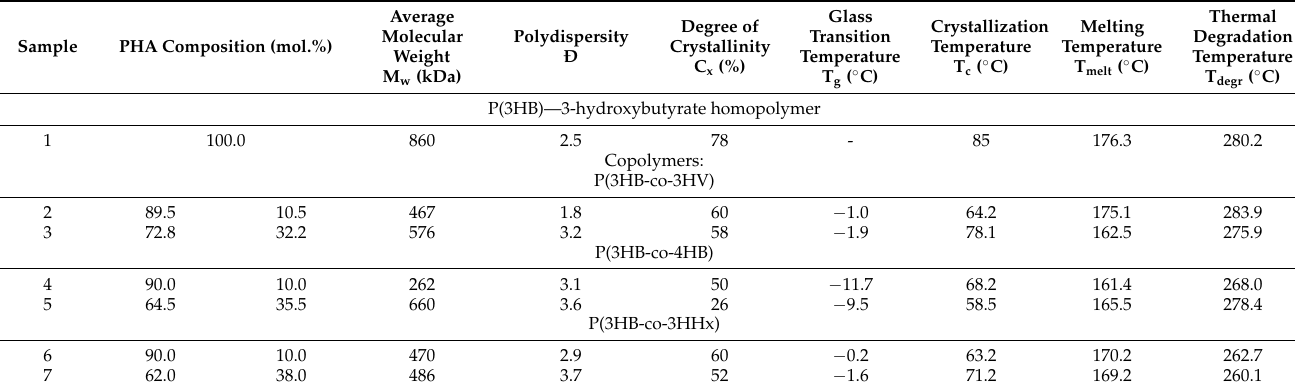
Table 1. Compositions and physicochemical properties of different